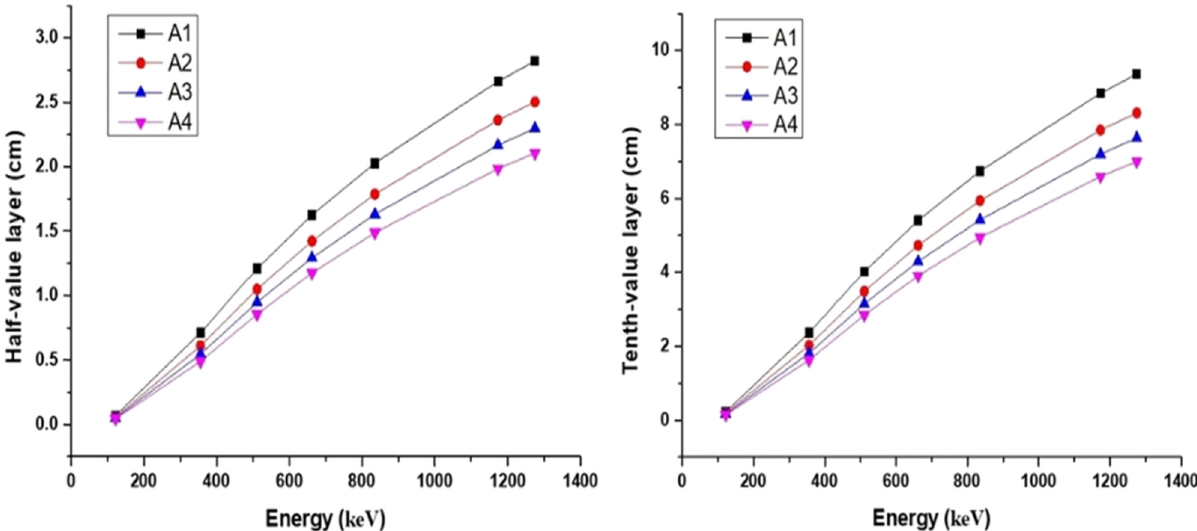
Figure 5: Plot of ( a ) half - value layer ( HVL ) and ( b ) tenth - value layer ( TVL ) using EPICS2017.